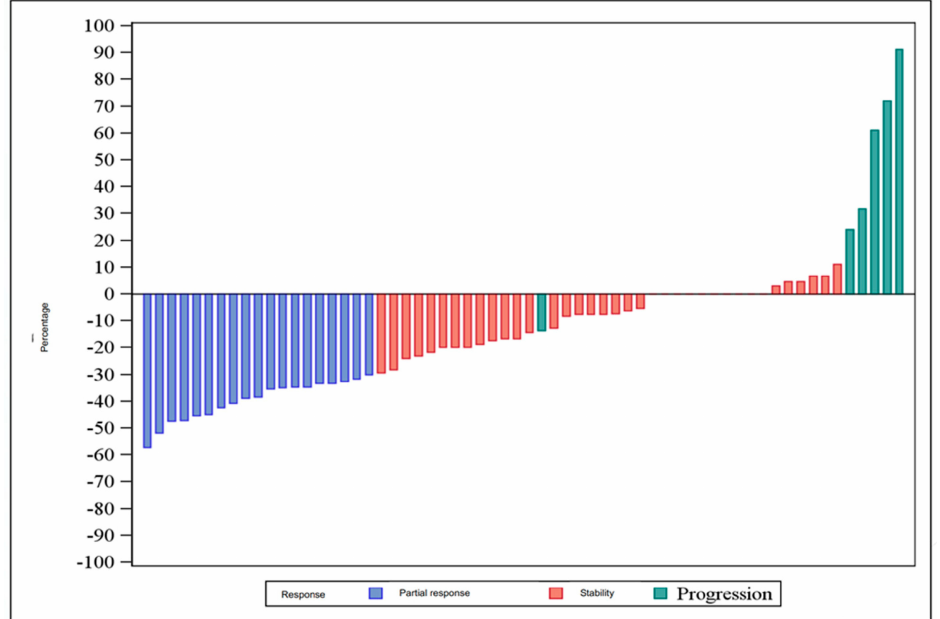
Figure 3. Waterfall graph: percentage change in tumor size according to RECIST criteria.